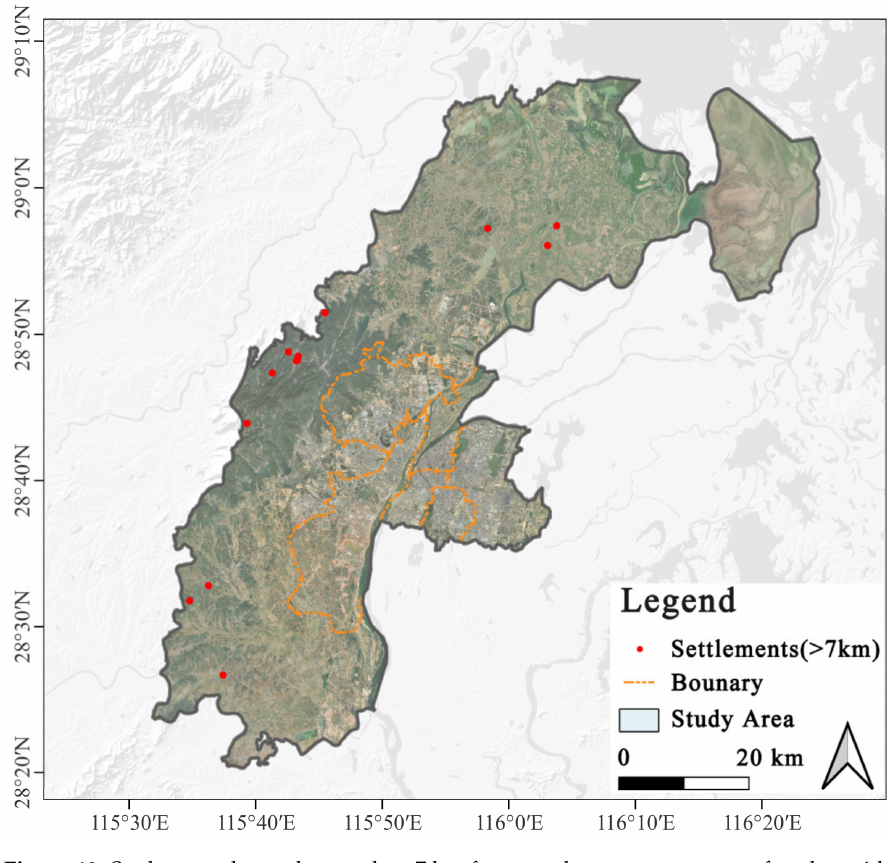
Figure 12. Settlements located more than 7 km from outdoor sports venues after the epidemic.